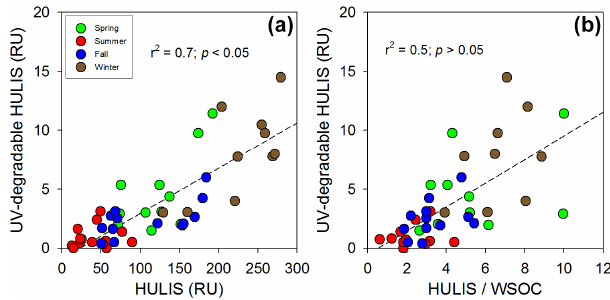
Figure 4. Plots of the (a) HULIS versus UV-degradable HULIS and the (b) ratio of HULIS to WSOC versus UV-degradable HULIS in the different seasons: spring (green), summer (red), fall (blue), and winter (brown). The dashed lines represent the regression lines.